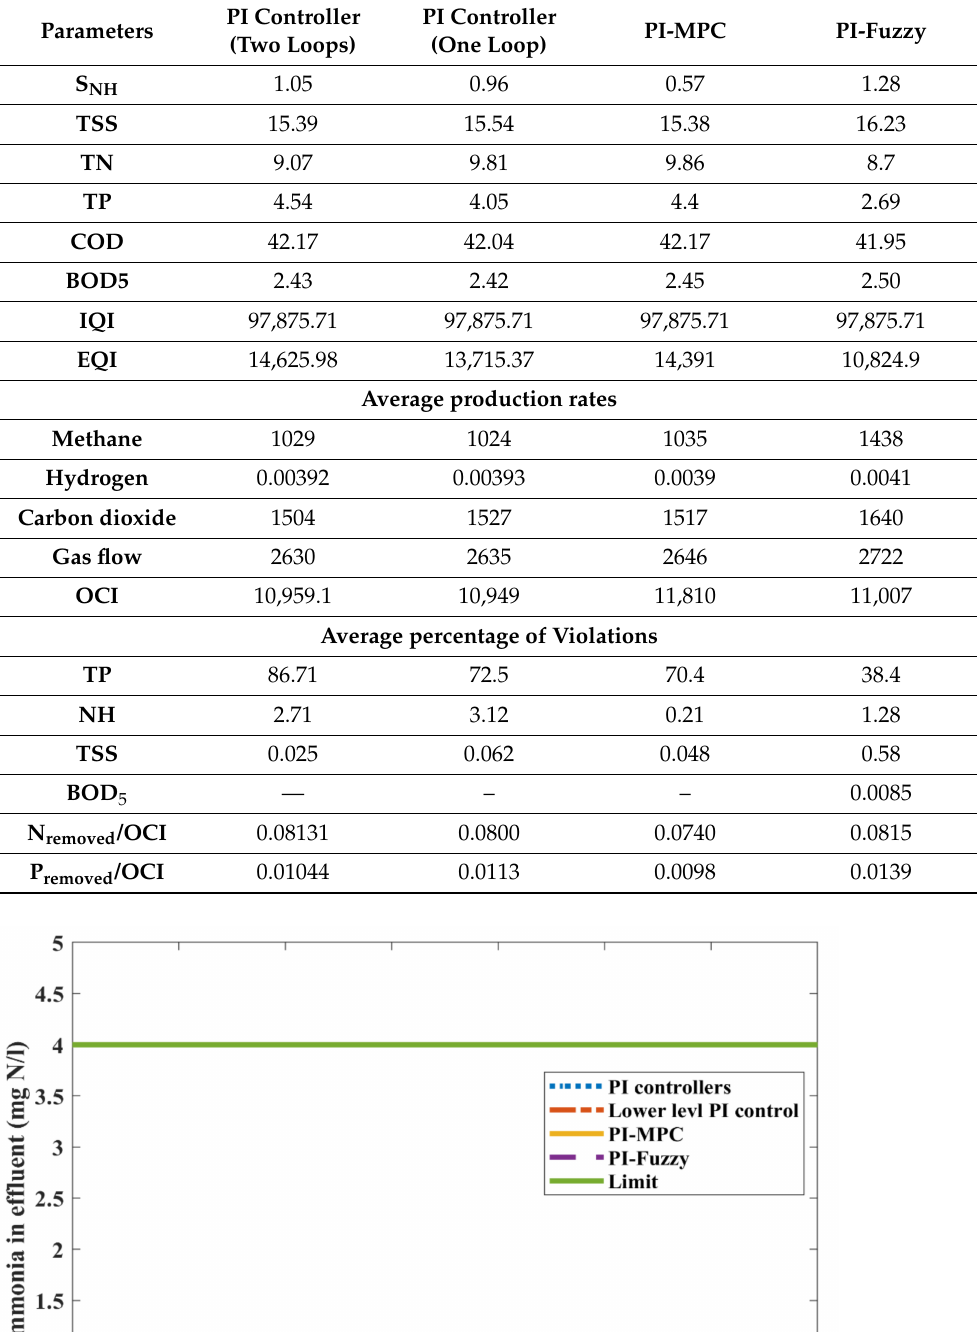
Table 6. Comparison of average concentration values of effluent discharge for four control strategies.